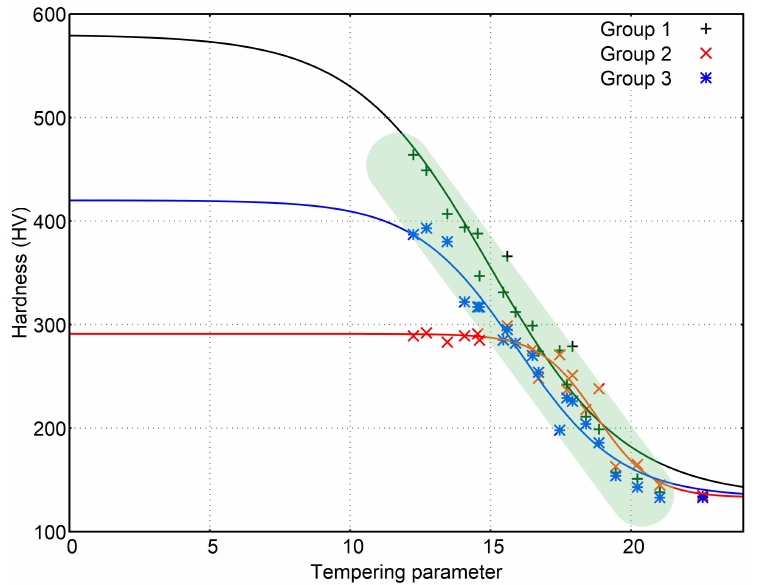
Figure 9. Mathematical relation between TP and hardness for the 3 groups of samples. Coefficients D and E are 0.417 and 14.97 for group 1, 1.000 and 18.76 for group 2 and 0.546 and 15.96 for group